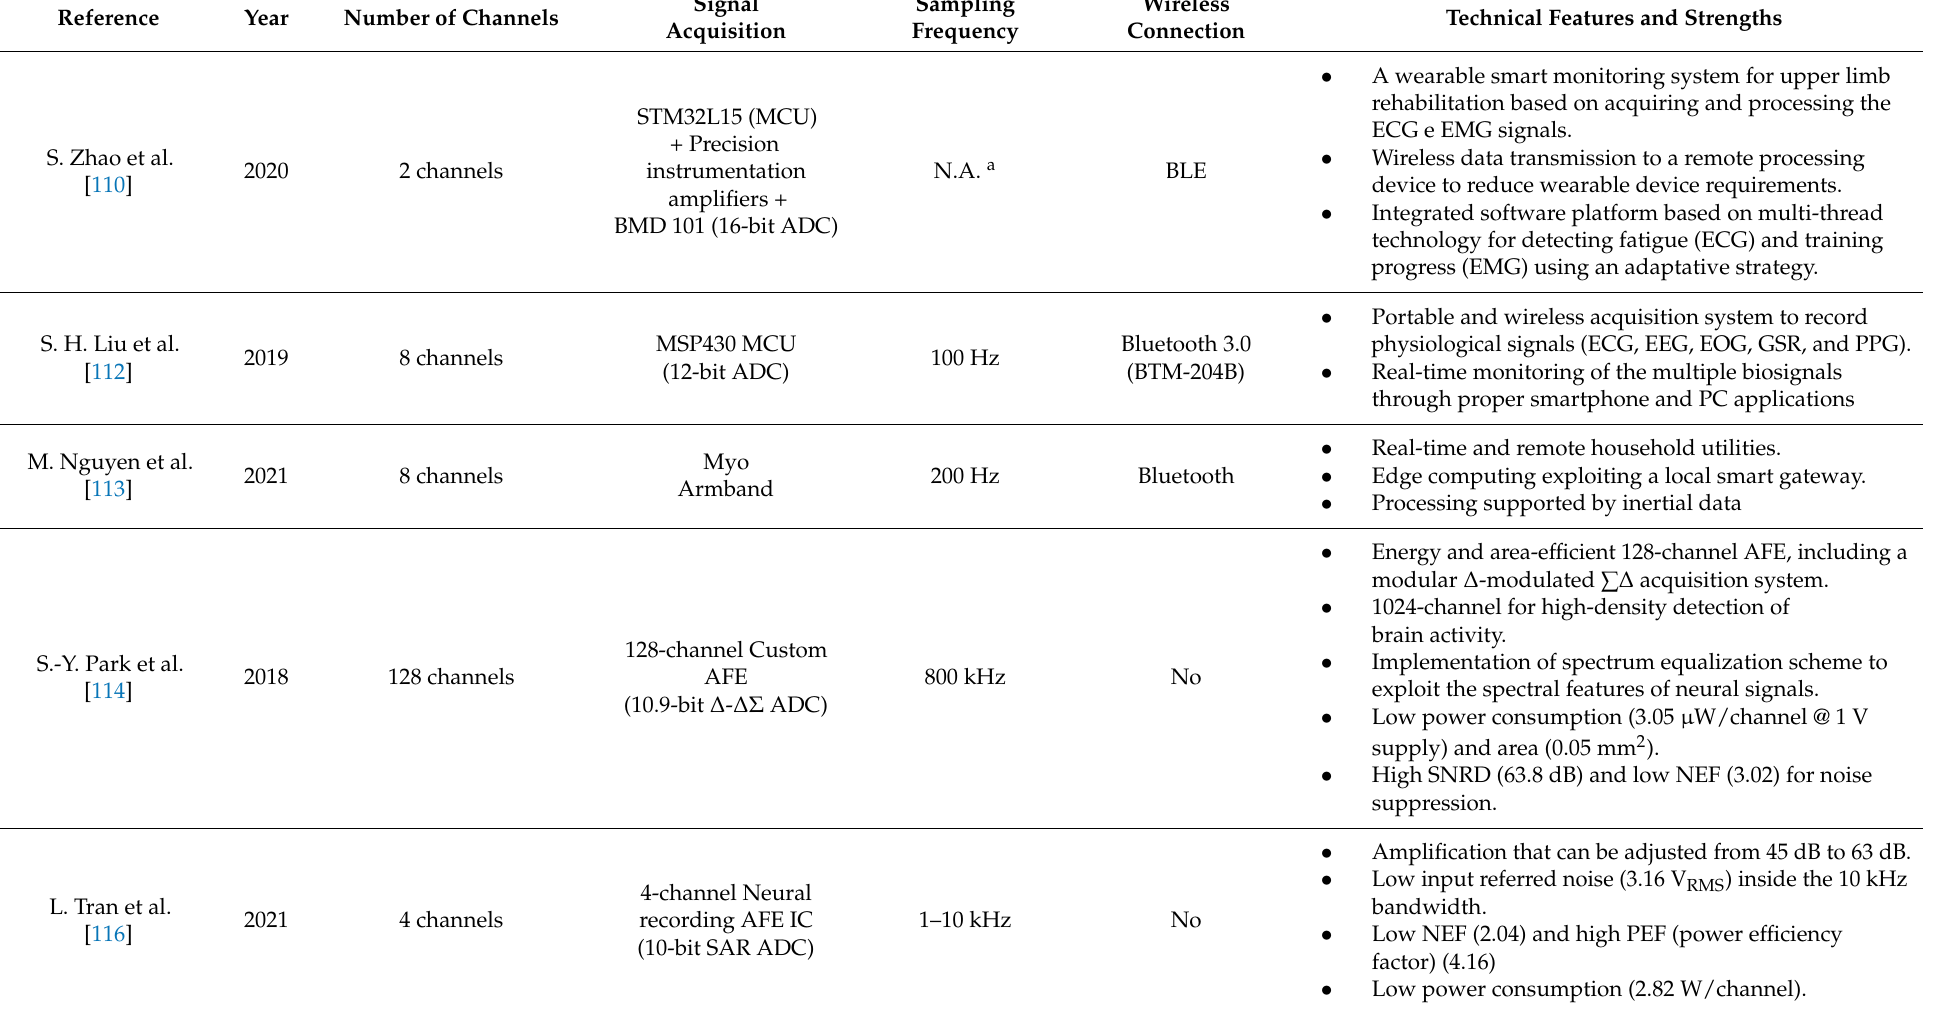
Table 1. Summarizing table of wearable monitoring systems reviewed in the manuscript (sorted by publication